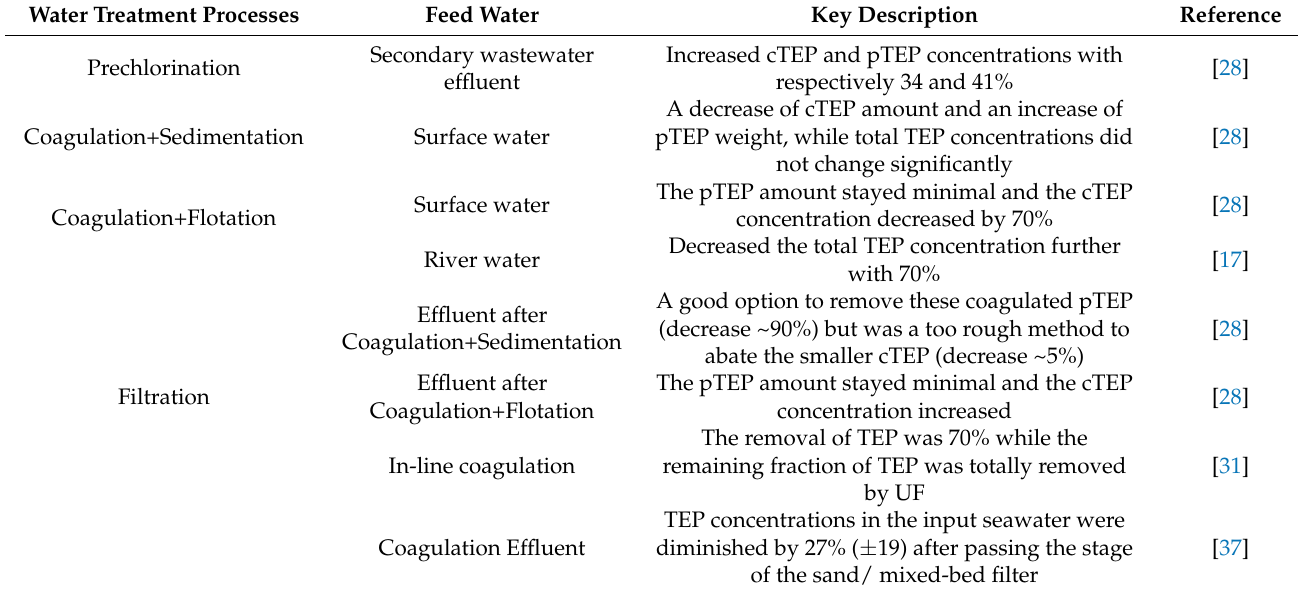
Table 2. The removal of TEP by different water treatment processes reported in literature. Water Treatment Processes Feed Water Key Description